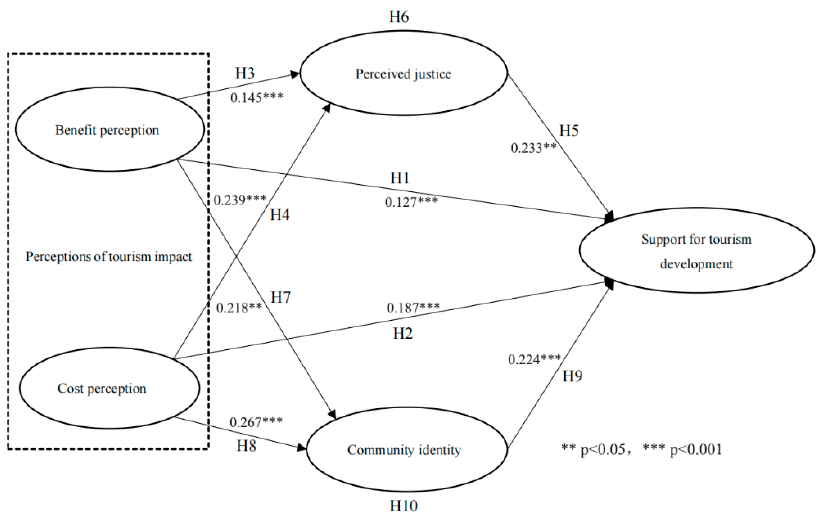
Figure 4. Results of structural equation